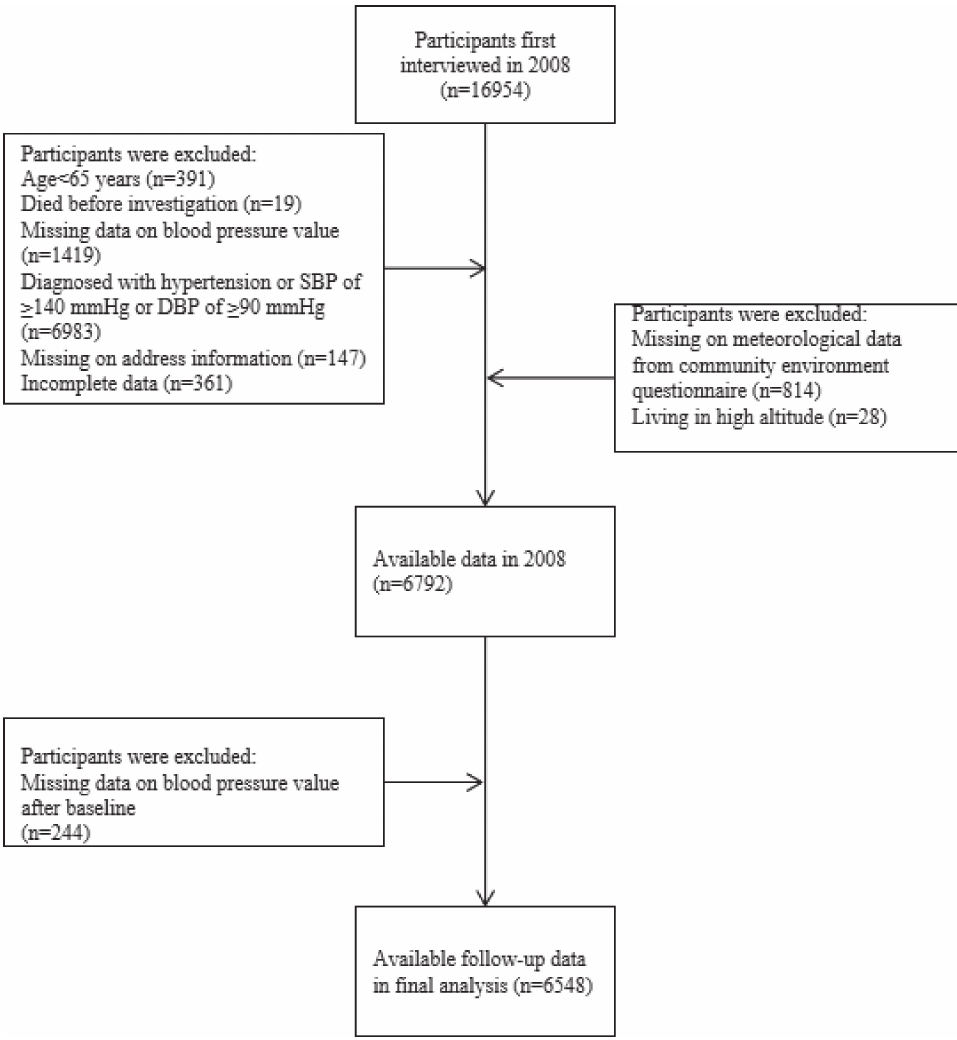
Fig. 1 Selection strategy of the study